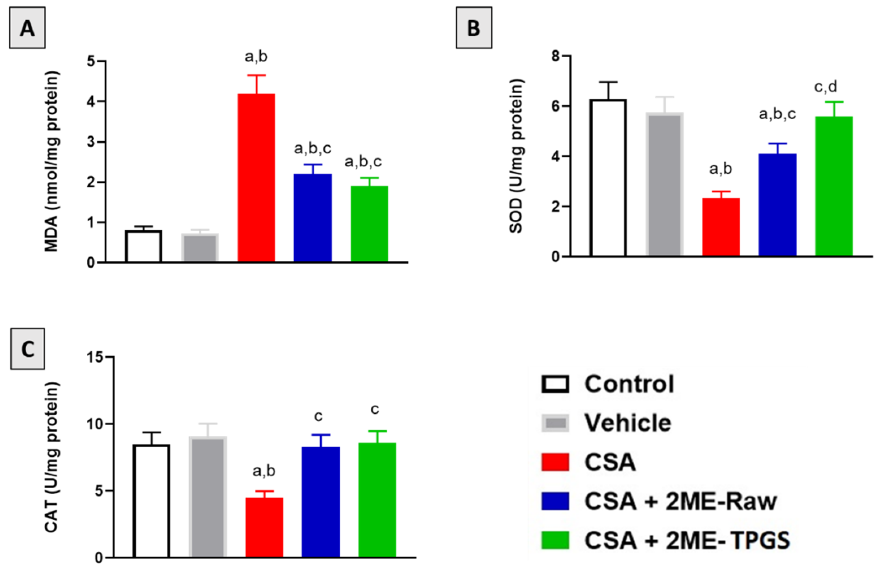
Figure 4. Effect of 2 ‐ ME ‐ TPGS on oxidative stress markers in CSA ‐ treated rats. ( A ) MDA; ( B ) SOD; and ( C ) CAT. Data are displayed as mean ± SD ( n = 6). a: Significantly different from respective Control at p < 0.05; b: significantly different from Vehicle at p < 0.05; c: significantly different from CSA at p < 0.05; d: significantly different from CSA + 2ME ‐ Raw at p < 0.05.